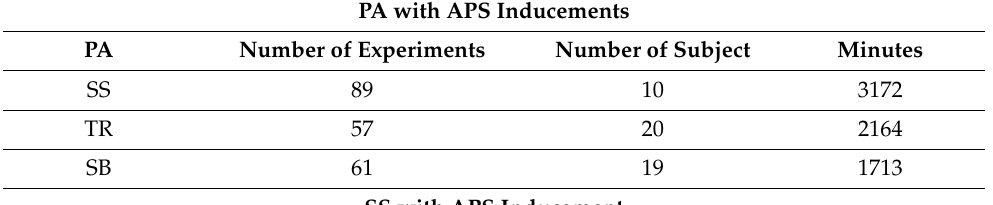
Table 3. Experiments Conducted for Data Collection